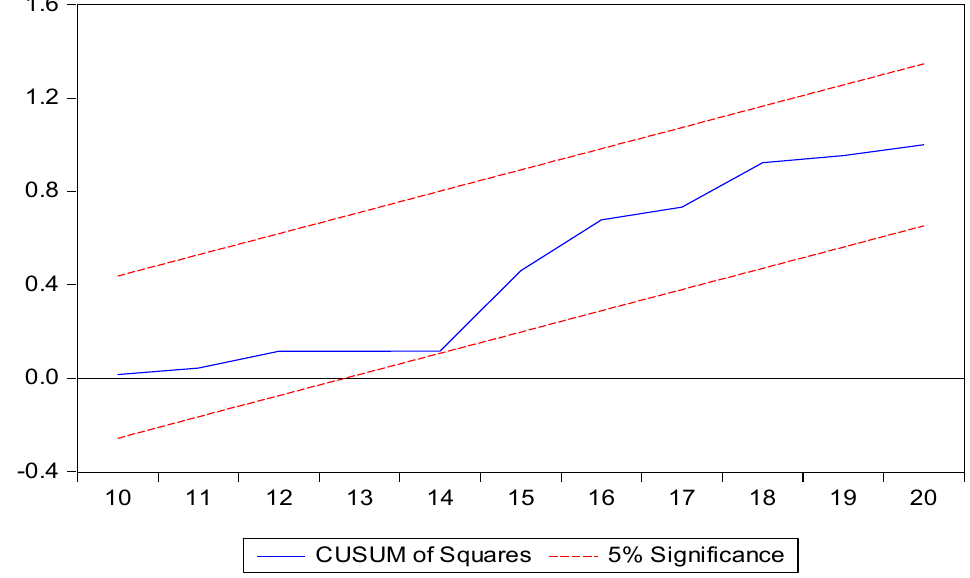
Figure 2. CUSUM Square